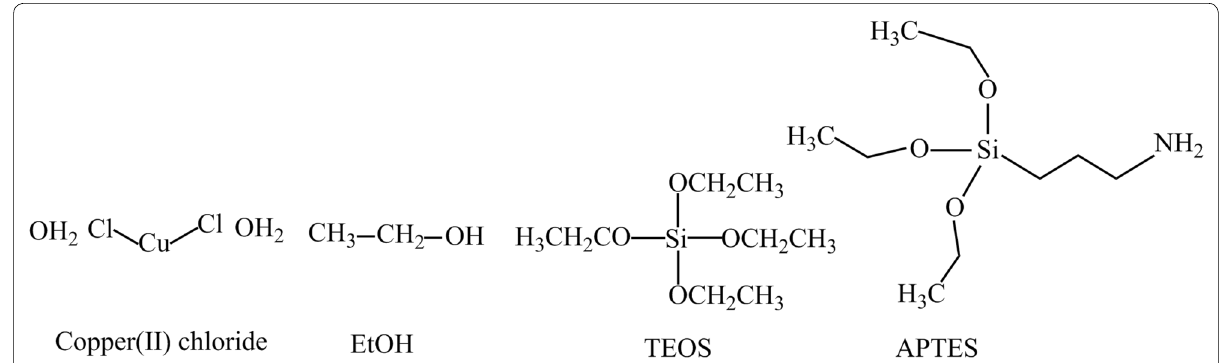
Fig. 1 Chemical formula of the main preservative compounds used in the